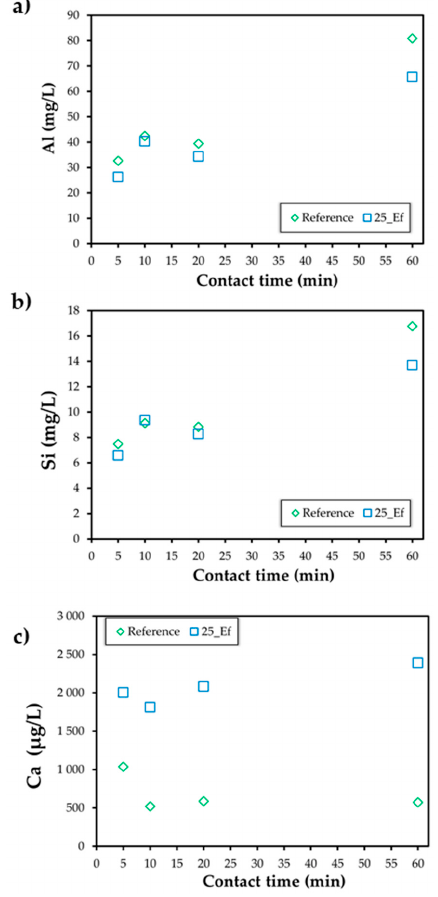
Figure 4. Dissolution of Al ( a ), Si ( b ), and Ca ( c ) for the studied compositions.